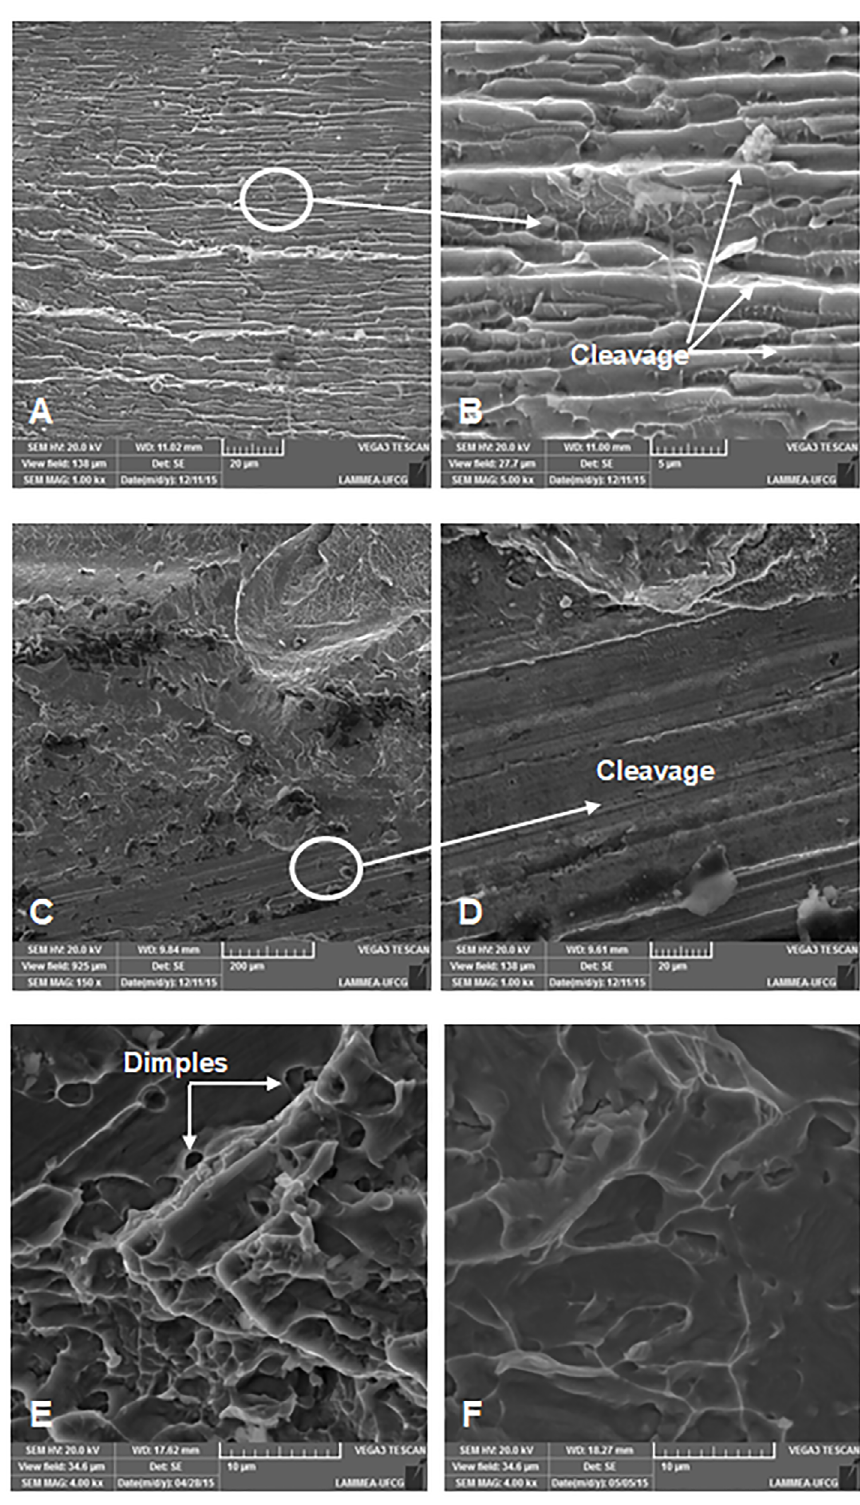
Figure 11. SEM images of the fracture surfaces (a,b) D11; (c,d) D12; e – S11 and f –